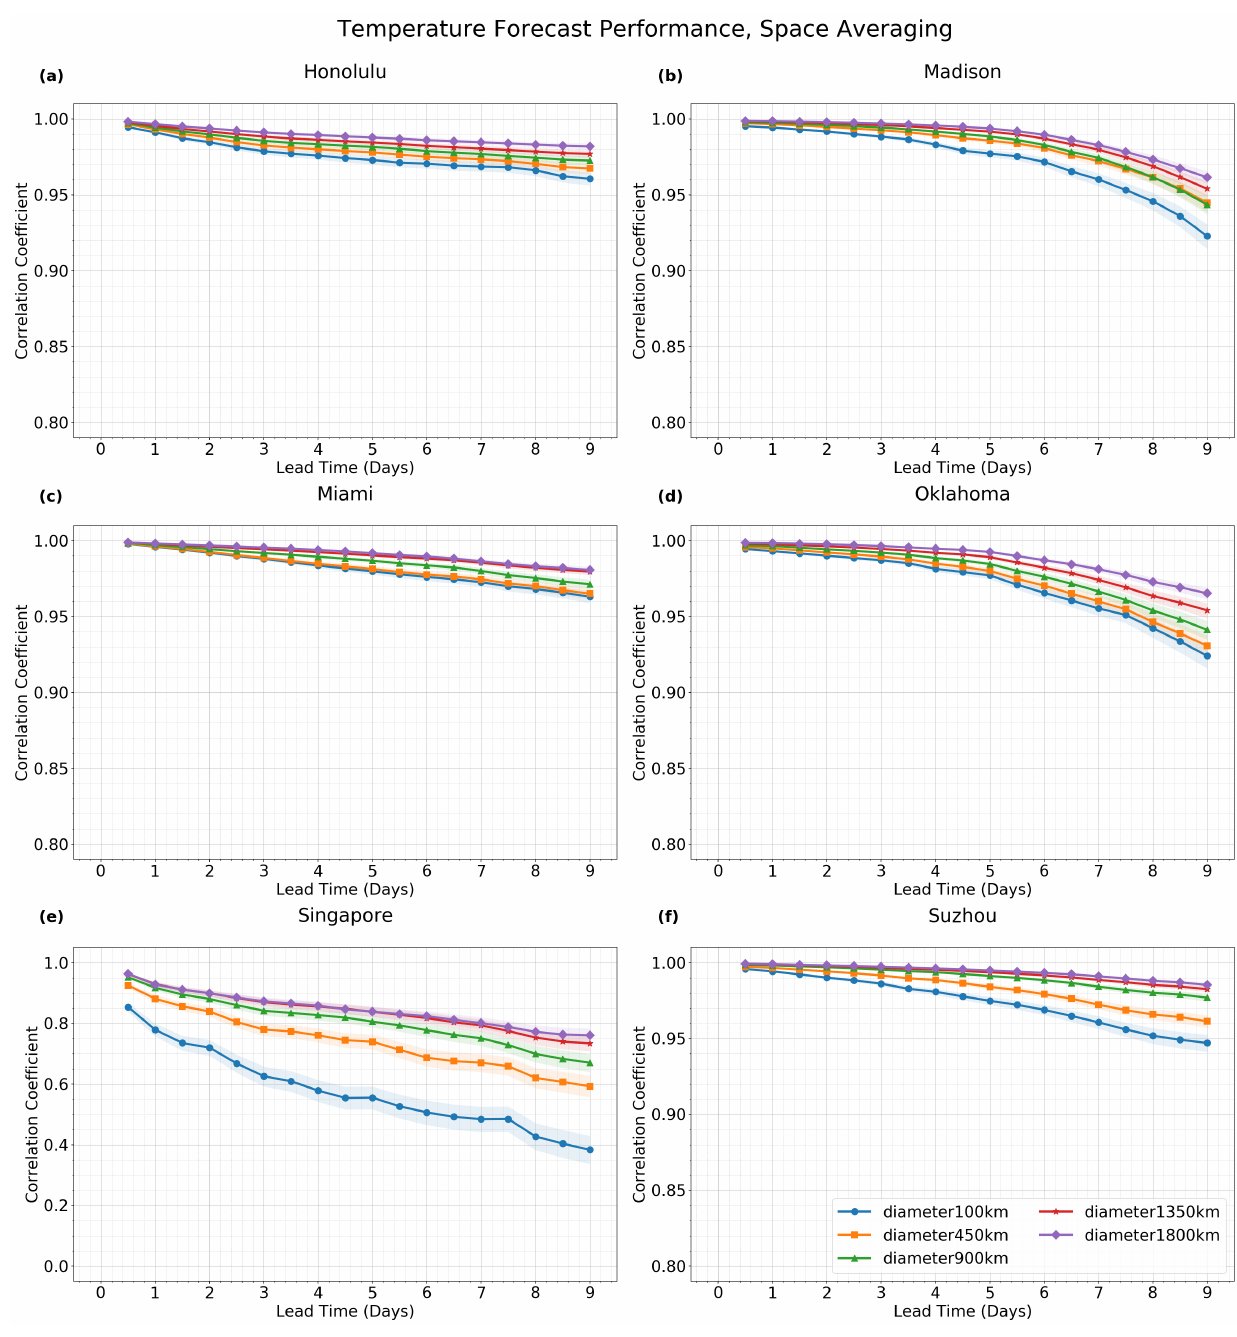
Figure 4. Effects of spatial averaging on forecast performance, for surface temperature, with 1-day time averaging, at several locations around the globe: ( a ) Honolulu, Hawaii (21 ◦ N, 158 ◦ W), ( b ) Madi- son, Wisconsin (43 ◦ N, 89 ◦ W), ( c ) Miami, Florida (26 ◦ N, 80 ◦ W), ( d ) Oklahoma City, Oklahoma (35 ◦ N, 98 ◦ W), ( e ) Singapore (1 ◦ N, 104 ◦ E), and ( f ) Suzhou, China (31 ◦ N, 120 ◦ E). Compare to the effects of time averaging from Figure